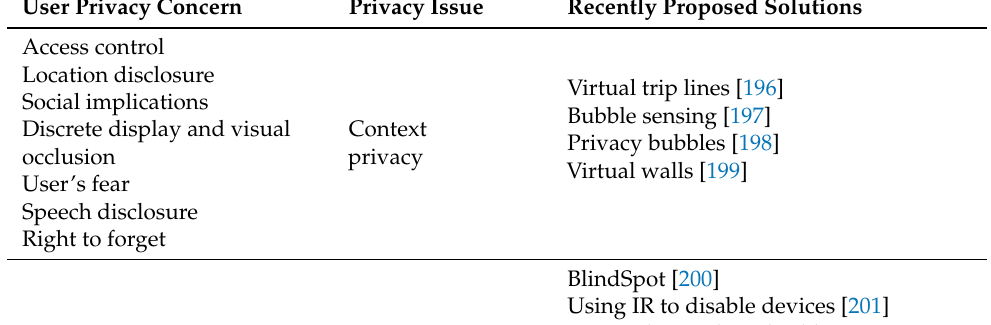
Table 7. Privacy concerns and issues for wearables (adapted from